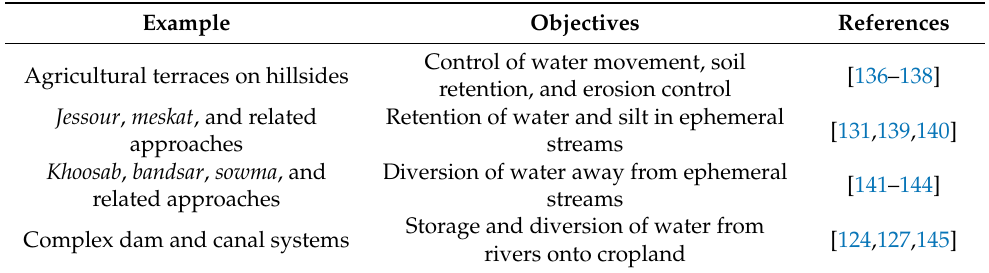
Table 1. Examples of early approaches to bring water, energy, and food into nexus. Example